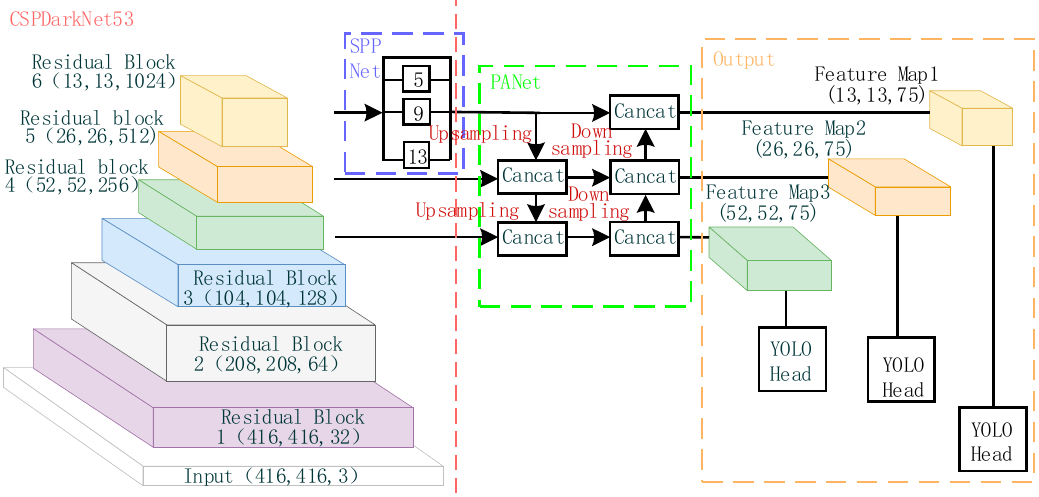
Figure 3. Original YOLOv4 network structure.